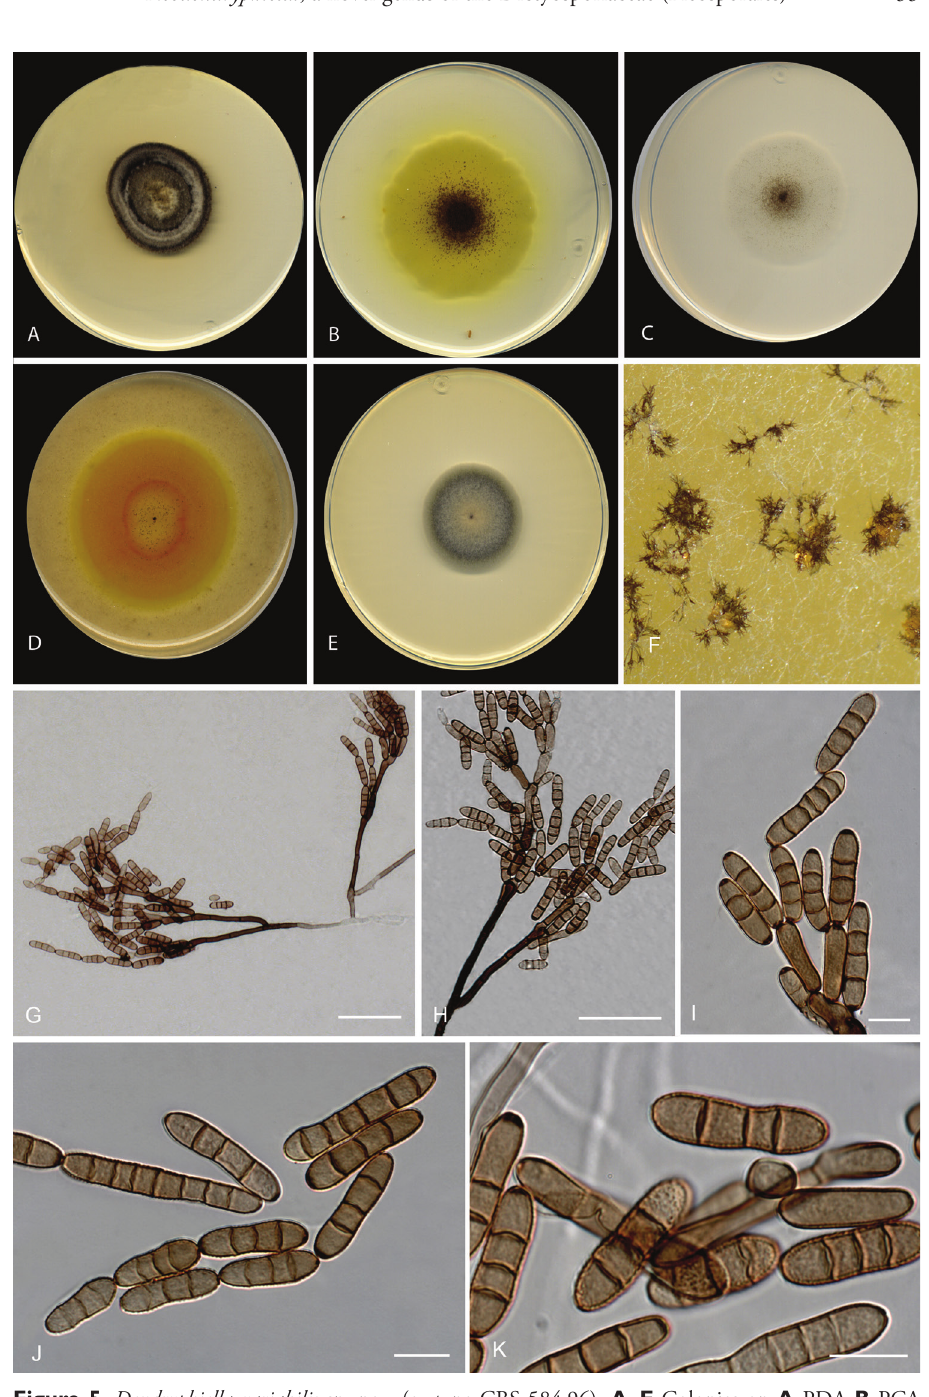
Figure 5. Dendryphiella variabilis sp. nov. (ex-type CBS 584.96). A–E Colonies on A PDA B PCA C SNA D OA E MEA at 25 °C after 14 d F Exudates and conidiophores produced on OA G–K Conidi- ophores and conidia. Scale bars: 50 μm ( G–H ), 10 μm ( I–K